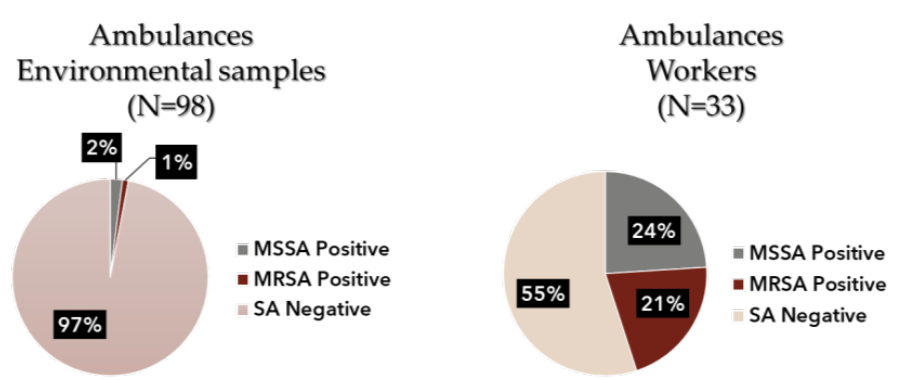
Figure 3. MRSA prevalence in the ambulances and crew .